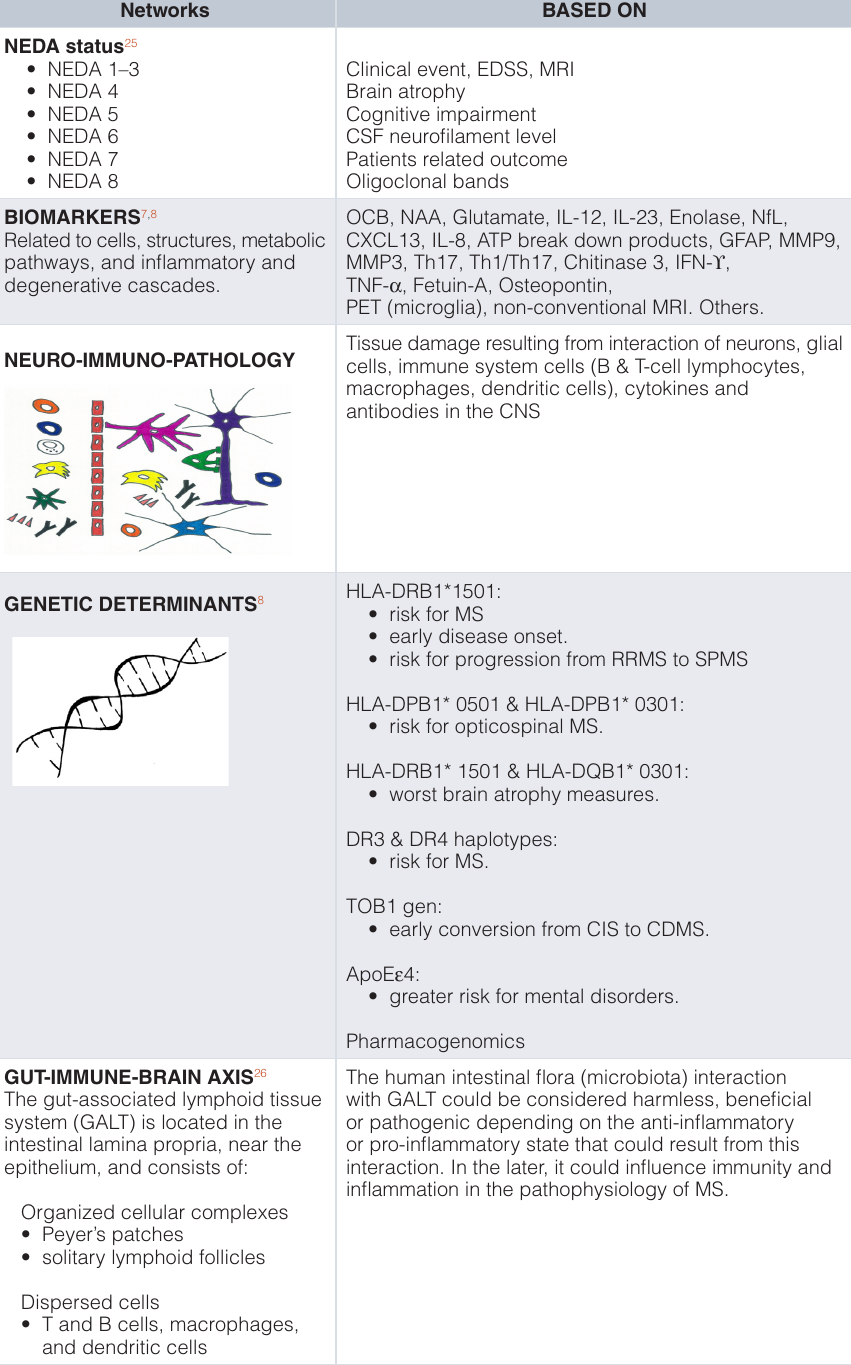
Table 1. From clinical assessment to application of systems biology in